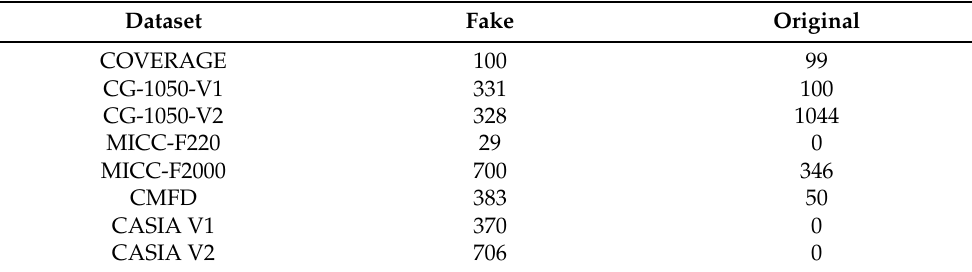
Table 4. Unified dataset: number of images taken from single datasets.